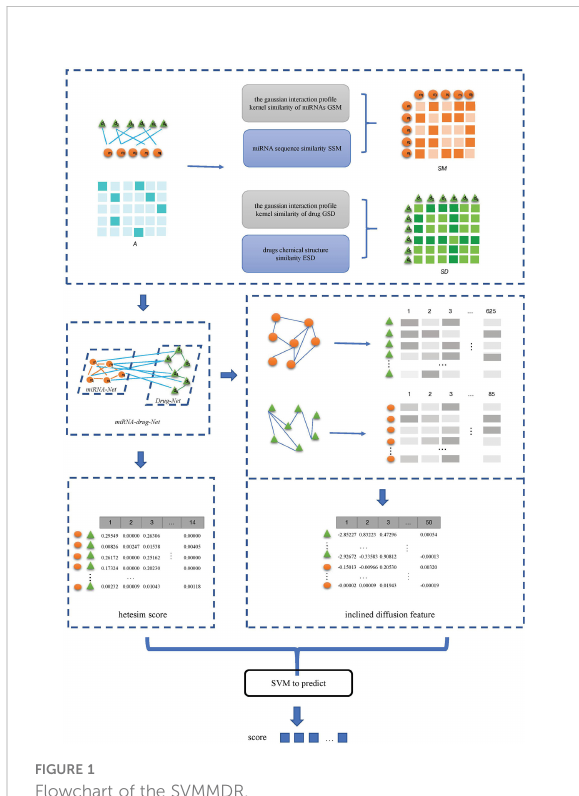
FIGURE 1 Flowchart of the